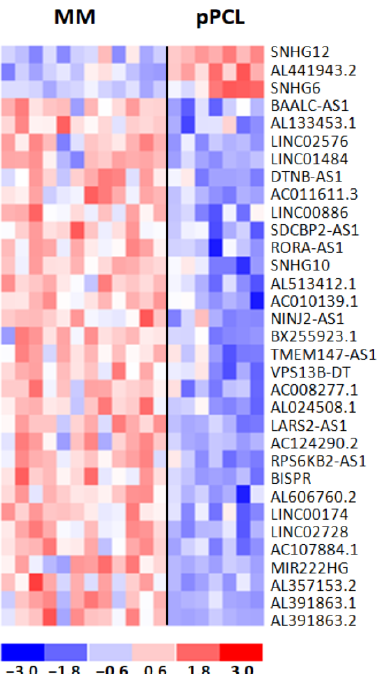
Figure 5. Heatmap of the 33 differentially expressed lncRNAs in 12 MM and 7 pPCL patients with t(11;14) chromosomal translocation. The colored scaled bar represents standardized rows by subtracting the mean and divided by the standard deviation.